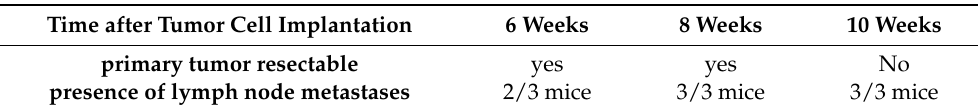
Table 1. Defining the optimal time point for cytoreductive primary tumor resection. Mice with orthotopic tumors were analyzed for the presence of lymph node metastases ( n = 3 per time point) and the resectability of the primary tumor ( n = 2 per time